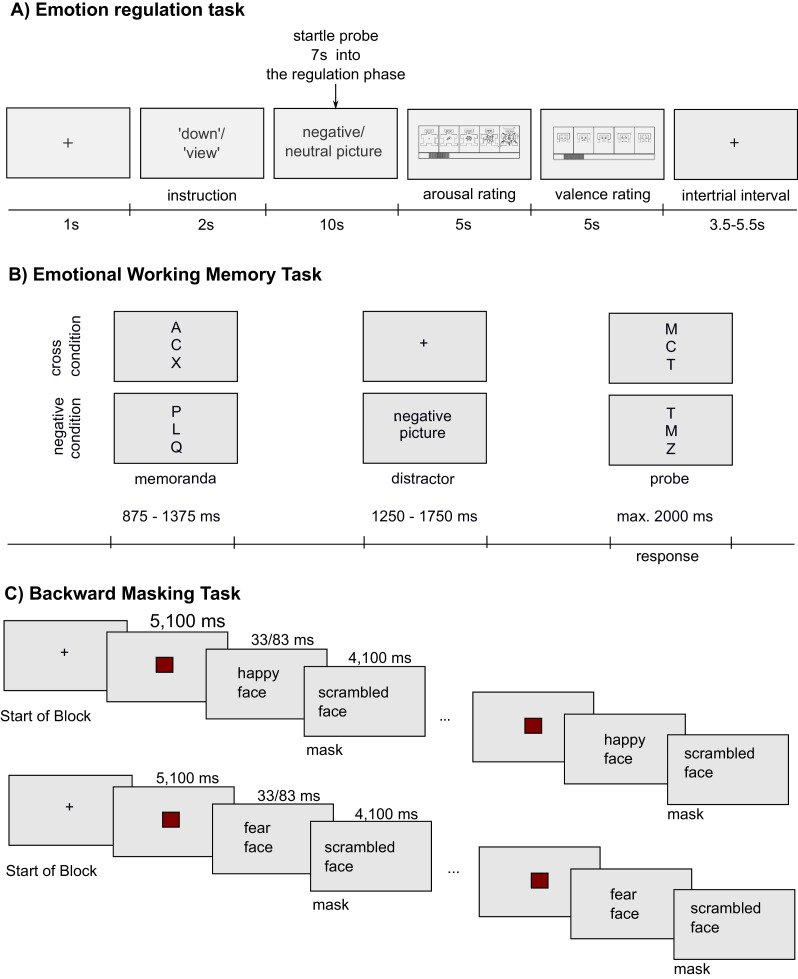
A) Experimental procedure of the emotion regulation task. Participants were instructed either to view negative and neutral pictures without modifying their emotions (‘view’; ‘neutral’ condition, respectively) or to downregulate their feelings toward negative pictures (‘down’ condition). Each trial began with a 2000 ms presentation of an instructional cue (‘view’, ‘down’), followed by a fixation cross displayed for 1000 ms. Next, a neutral or negative picture was presented for 10,000 ms. A startle probe (50 ms, 95 dB white noise burst) was presented through headphones at 6500 ms–9500 ms into the regulation phase). Self-assessment Manikins (SAM Ratings; Bradley and Lang, 1994) were presented after presentation of each picture. Participants rated a 1–9 Likert scale on how positive / negative and aroused / calm they felt at that moment. Lower scores on the valence scale indicated that they felt more positive; lower scores on the arousal scale indicated that they felt calmer. Intertrial intervals were jittered between 3500 and 5500 ms. Details about stimuli and the procedure can be found in the supplement. B) Experimental procedure of the Emotional Working Memory Task (EWMT), which is an adapted Sternberg item recognition task (Sternberg, 1966), modified by Oei and colleagues (Oei et al., 2009; Krause-Utz et al., 2012). Each trial started with the presentation of a set of three letters (memoranda, 875–1375 ms). After a delay phase of 1250–1750 ms, another set of three letters appeared on the screen (probe, 2000 ms). Next, a blank screen appeared (intertrial interval, 550–1050 ms). Participants had to press the left or right button to indicate whether they recognized one of the memoranda-letters in the probe. In half of the trials, one of three memoranda was present. During the delay interval, no distractor (i.e., a fixation cross; ‘cross’ condition) or a distractor (i.e., an aversive picture; ’negative’ condition) was presented. Details of stimuli and the procedure can be found in the supplement. C) Experimental Procedure of the Backward Masking Task (BMT). Participants were instructed to identify photographs of faces expressing happy or fearful facial expressions. The BMT had a total of four conditions: happy or fearful facial expressions presented for 33 ms or 83 ms. A total of 4 blocks per condition were presented. Each block consisted of 8 consecutive pictures. Each block began with a fixation cross. Next, eight faces were shown for 33 ms or 83 ms, preceded by a red rectangle on a grey background for 5100 ms and followed by a mask (scrambled face) for 4100 ms. Details of the stimuli, procedure, and behavioral results are in the supplement.